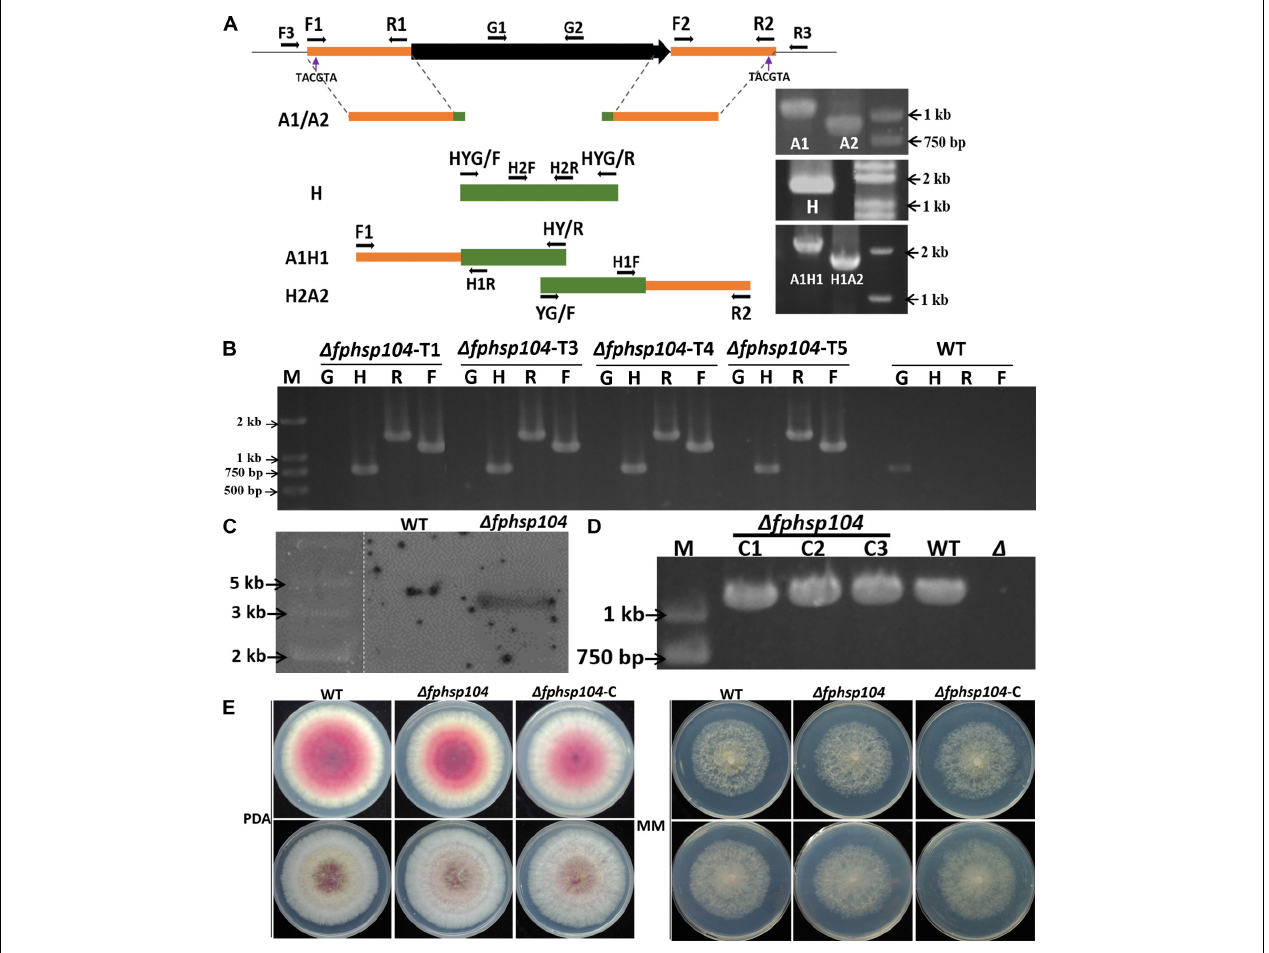
FIGURE 1 | Targeted gene replacement of FpHsp104 and genetic complementation. (A) Scheme for (cid:49) fphsp104 strain construction by homologous recombination. The 903-bp 5 (cid:48) -UTR (A1) and 1,108-bp 3 (cid:48) -UTR (A2) of FpHsp104 from Fusarium pseudograminearum and 1,380 bp hph (H) were amplified, respectively. Two fusion products, A1H1 (1,378 bp) and A2H2 (1,751 bp), were amplified by overlapping PCR. (B) Results of PCR analysis, in which a 750-bp fragment of the hph gene (H), a 1,118-bp fragment of FpHsp104 and hph upstream cassette (F), and a 1,436-bp fragment of FpHsp104 and hph downstream cassette (R) were amplified from (cid:49) fphsp104 mutants. A 1,087-bp fragment of the FpHsp104 gene was amplified from the wild-type (WT) strain. (C) Southern blotting analysis of WT and (cid:49) fphsp104 -T4 strains with a 750-bp fragment as a probe. The genomic DNA of each strain was digested with Sna BI. (D) Complementation strains were detected with PCR analysis, in which a 1,087-bp fragment of the FpHsp104 gene was amplified. (E) Phenotypes of WT, (cid:49) fphsp104 , and (cid:49) fphsp104 -C strains. All strains were inoculated on potato dextrose agar (PDA) and minimal medium (MM) for 3 days at 25 ◦ C.